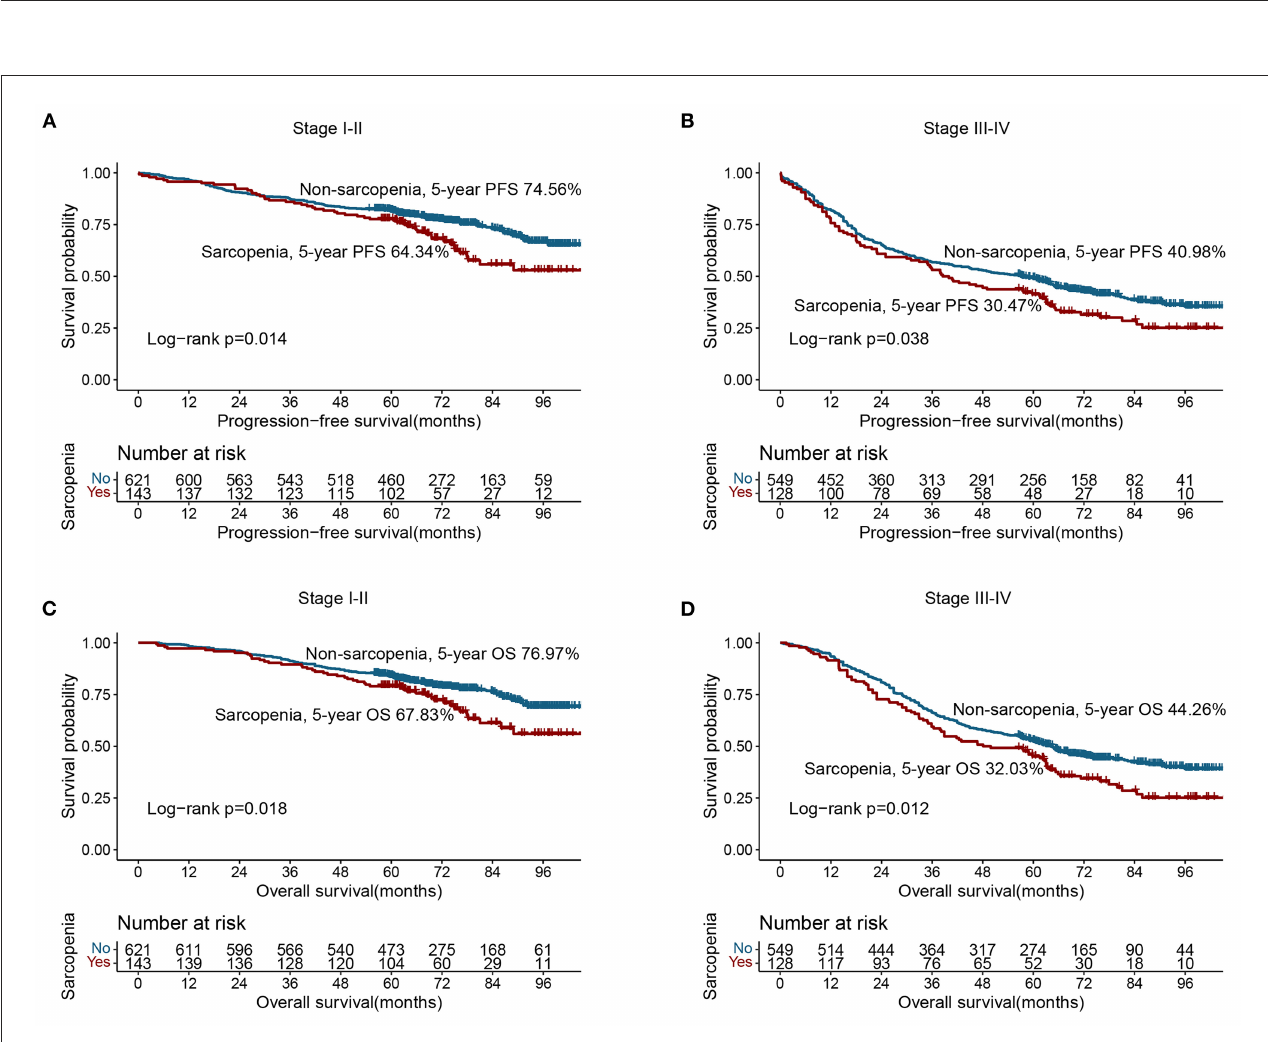
FIGURE2 Stratified survival analysis of sarcopenia based on different TNM stage. (A) Progression-free survival of stage I–II; (B) Progression-free survival of stage III–IV; (C) Overall survival of stage I–II; (D) Overall survival of stage